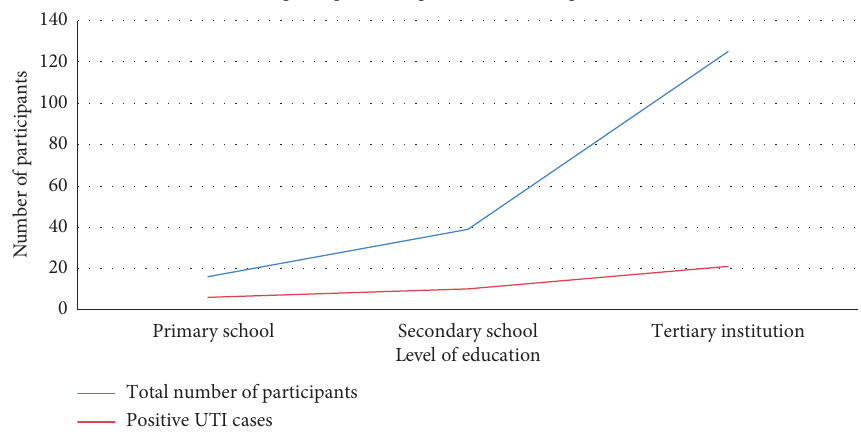
Figure 3: Total number of participants and positive UTI cases per level of education